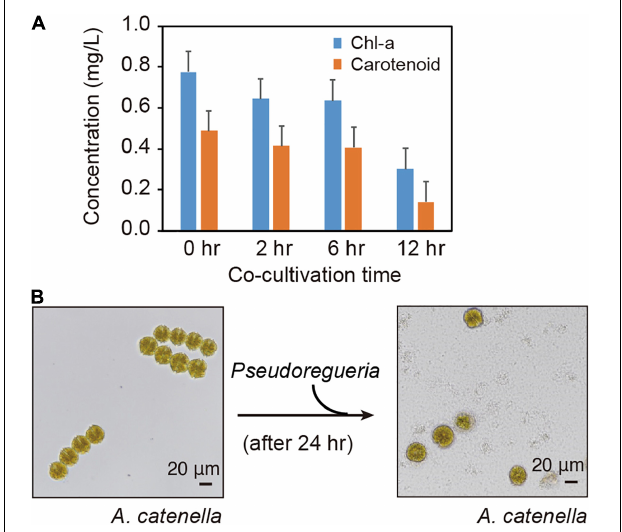
FIGURE 1 | Co-culture of Alexandrium catenella and Pseudoruegeria sp. (A) . Changes in Chl-a and carotenoid concentrations in A. catenella were measured at 0 (pure), 2, 6, and 12 h of co-culture. (B) The morphological changes of A. catenella were observed before and after treatment with Pseudoruegeria sp. (after 24